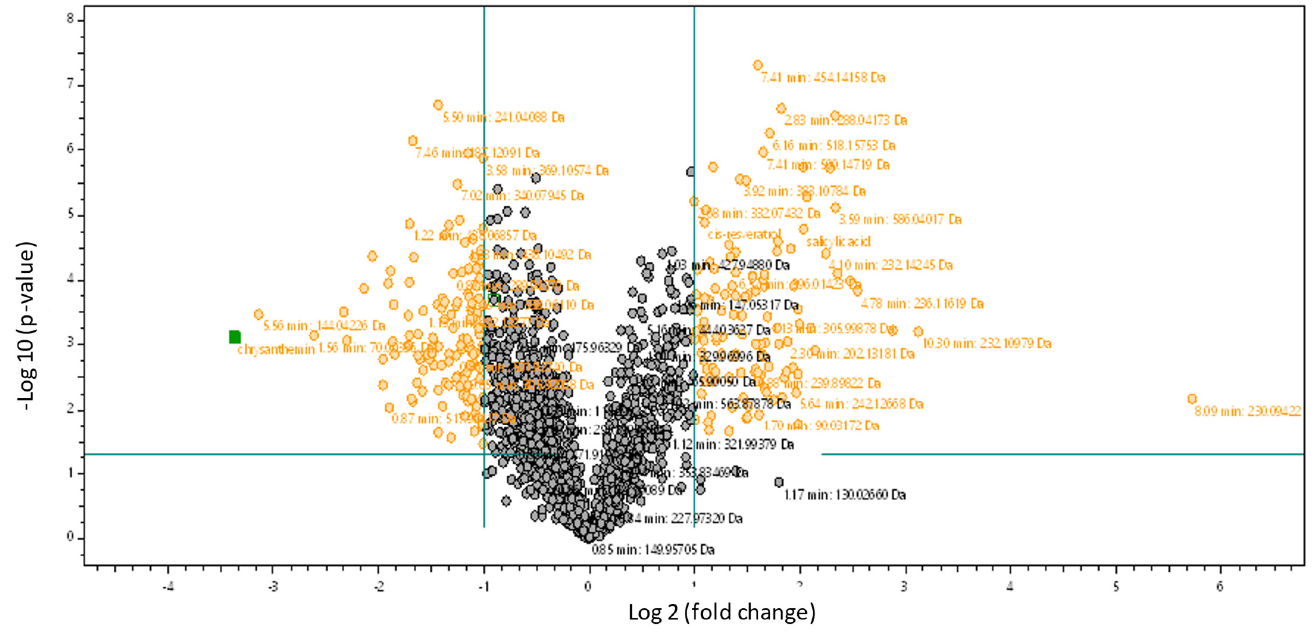
Figure 5. Volcano plot of the comparison of the wine samples from both terroirs. The plot represents the − log10 p -value on the y-axis vs. the log2 fold change on the x-axis (when p < 0.05, the metabolites were considered statistically different). A negative or positive log2 fold change indicates the higher intensity of the metabolites in the wine 1 and wine 2 samples, respectively. Compounds marked in green correspond to the one that was present only in terroir 1, with both the relevant fold change and p < 0.05.